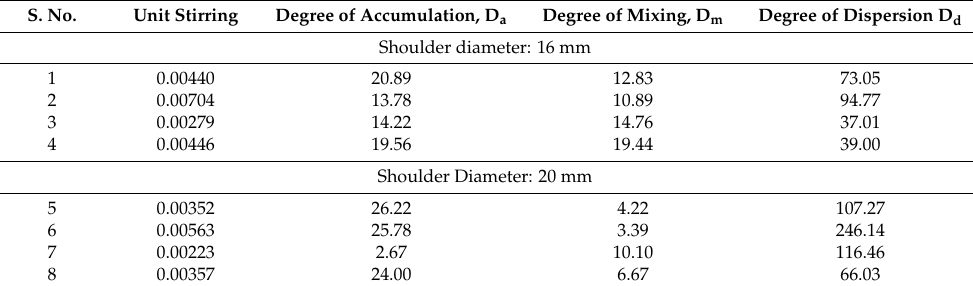
Table 4. Effect of derived parameters on the stages of particle distribution.